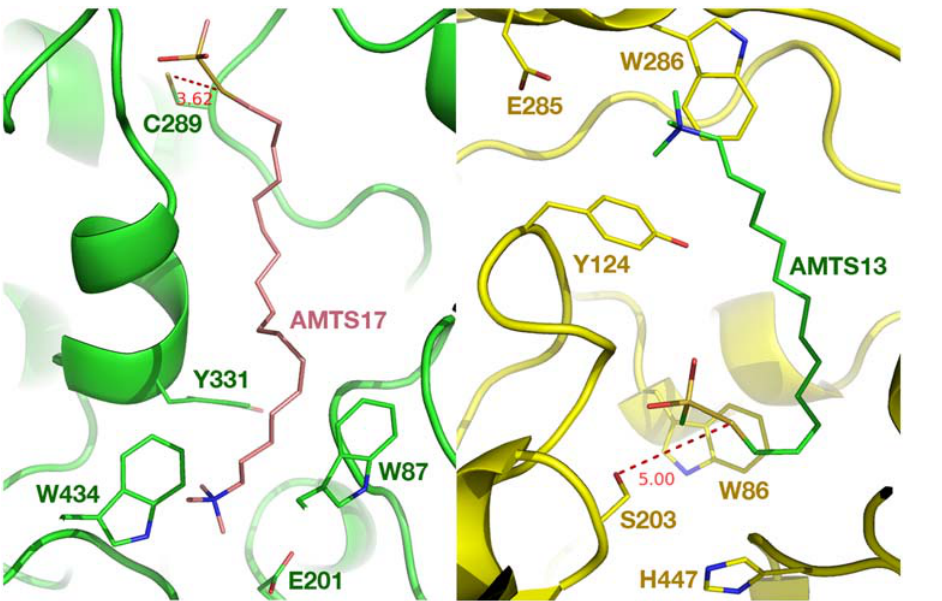
Figure 4. Cross-section view of the multiple-molecular-dynamics-simulation-refined three-dimensional models of the greenbug and human acetylcholinesterases in complex with AMTS17 and AMTS13, respectively. Left : The C, N, O, and S atoms are colored in magenta/green ( AMTS17 /AChE), blue, red, and yellow, respectively. Right : The C, N, O, and S atoms are colored in green/yellow ( AMTS13 /AChE), blue, red, and yellow,